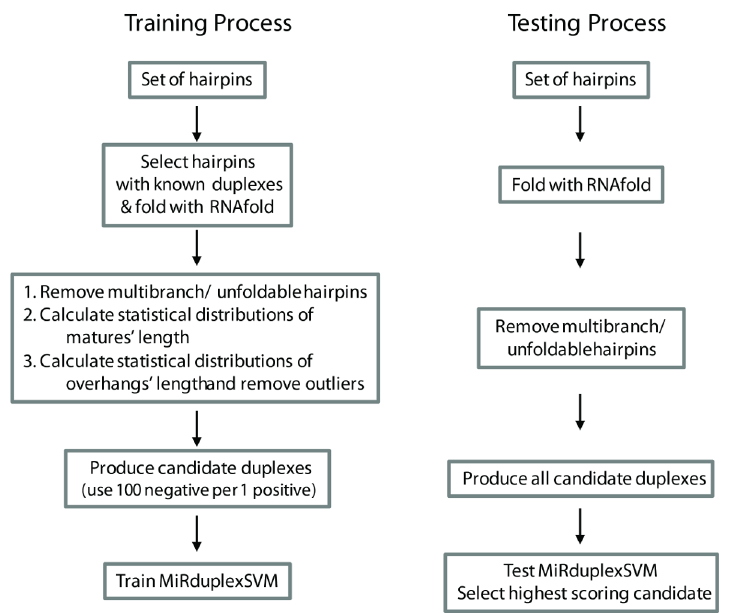
Fig 2. Flowcharts of the training and testing